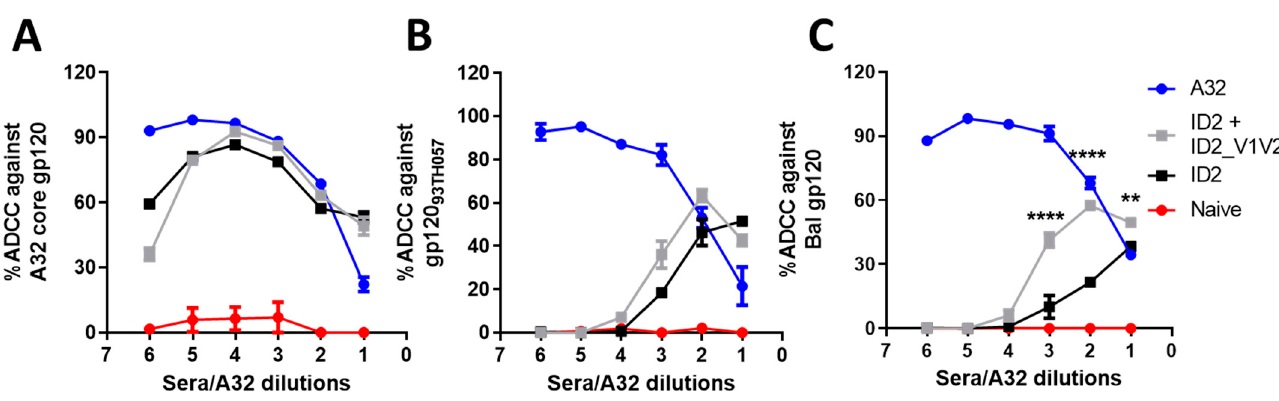
Figure 5. Sera RFADCC. A32 and sera were assessed for ADCC activity using the RFADCC assay against target cells coated with ( A ) gp120 93TH057 core, ( B ) gp120 93TH057 and ( C ) gp120 Bal. Sera was diluted 1:50 and A32 to 10 µg/mL for dilution 1; both were then serially diluted 1:4 to form a dilution curve. Sera and A32 were analyzed in triplicate, with one PBMC donor, and displayed as the mean ± SEM. Statistical analysis was via two-way ANOVA with Sidak multiple comparison correction to detect differences between the ID2 and ID2-V1V2 samples; ** p < 0.01, **** p < 0.0001.